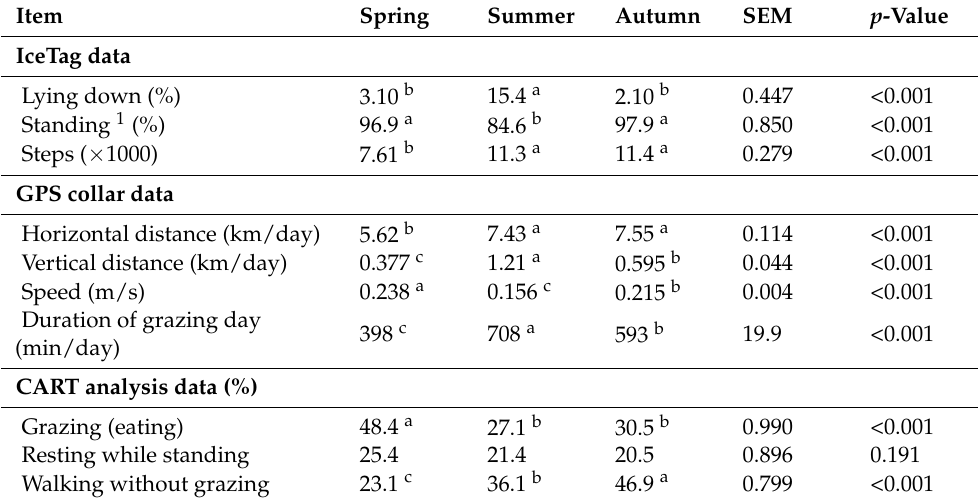
Table 2. Seasonal variation in grazing activities of goats in a Mediterranean forest rangeland of northern